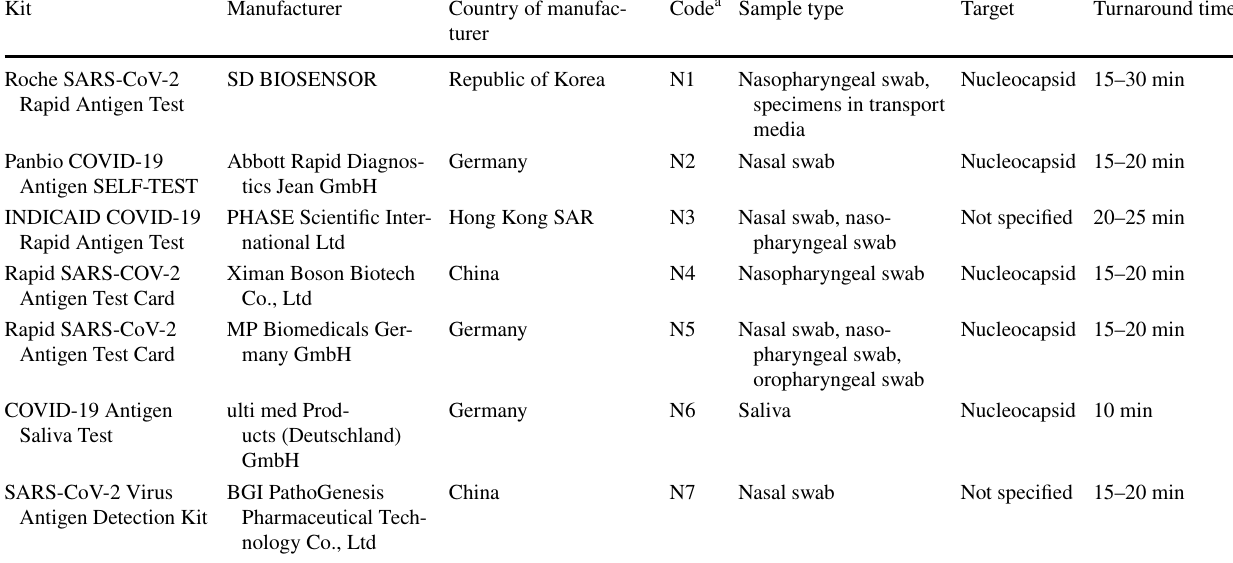
Table 1 Rapid antigen detection kits evaluated in the present study